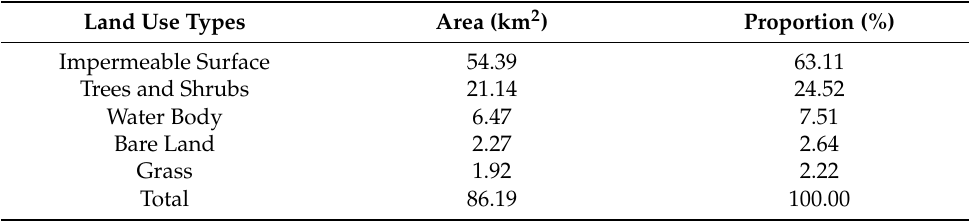
Table 4. Statistical table of land use coverage in the main urban area of Guangzhou.